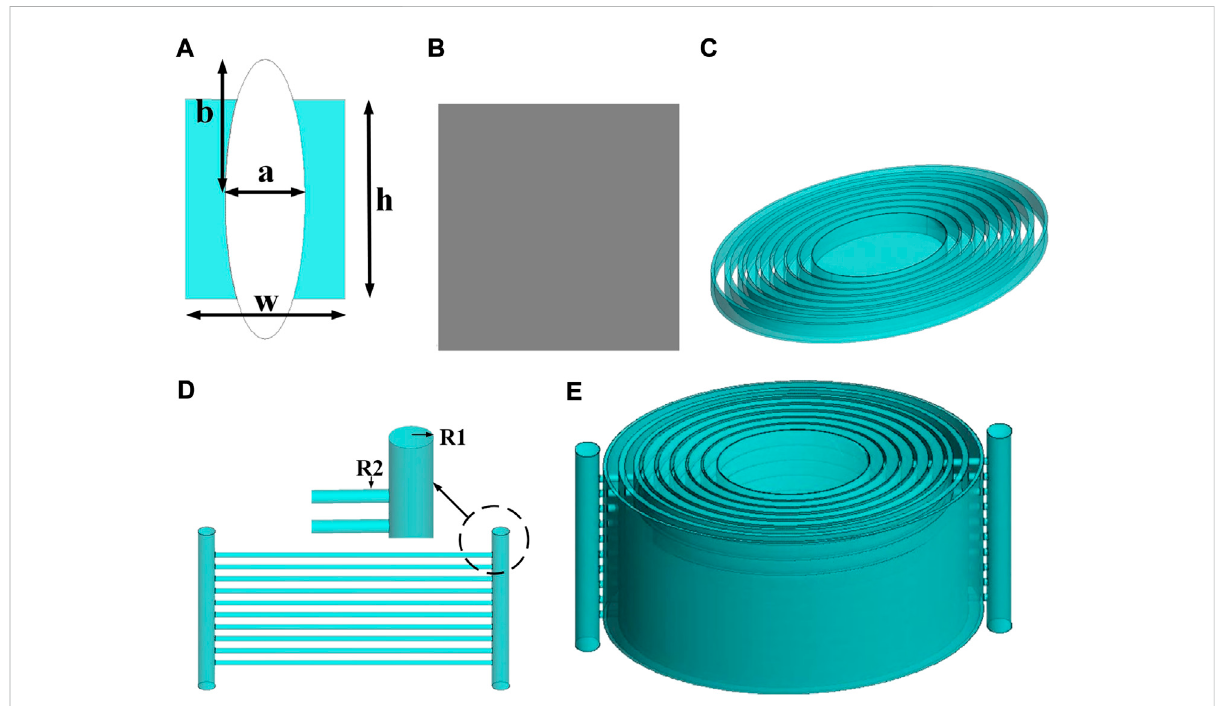
FIGURE 2 Schematicof the proposed Luneburg lens. (A) The ellipse ring-type unit. (B) The rectangle ring-type unit. (C) The single layer lens composed of periodic unit cells. (D) The supporting frame. (E) The elliptical Luneburg lens.